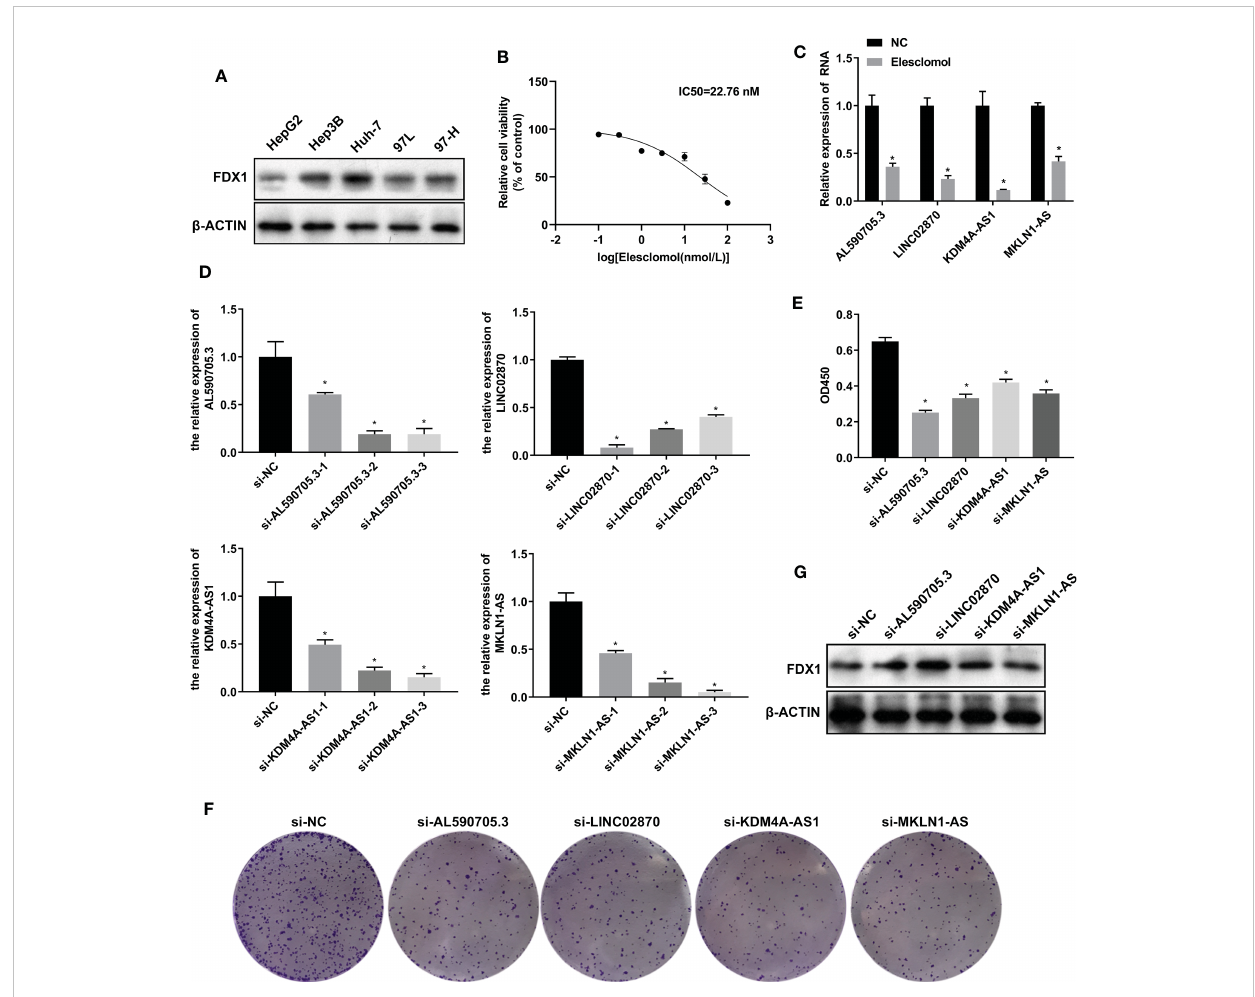
FIGURE 4 LncRNA AL590705.3, LINC02870, KDM4A-AS1, and MKLN1-AS participated in cuproptosis. (A) Westen blotting detected FDX1 expression in HepG2, Hep3B, Huh-7, 97L, and 97H cells. (B) CCK-8 was used to evaluated the IC50 value of elesclomol in Huh-7 cells after treated with elesclomol in different concentration (0, 0.1, 0.3, 1, 3, 10, 30, and 100 nM) for 48 h. (C) qPCR detected the expression levels of AL590705.3, LINC02870, KDM4A- AS1, and MKLN1-AS after treated with elesclomol for 24 h. (D) qPCR detected the interfere effective of siRNAs target for AL590705.3, LINC02870, KDM4A-AS1, and MKLN1-AS respectively. Huh-7 cells were transfected with siRNAs for 24 h, then cells were collected for qPCR analysis. (E) CCK-8 was used to evaluated the ability of proliferation. Huh-7 cells were transfected with siRNAs for 48 h, and then CCK-8 was conducted. (F)